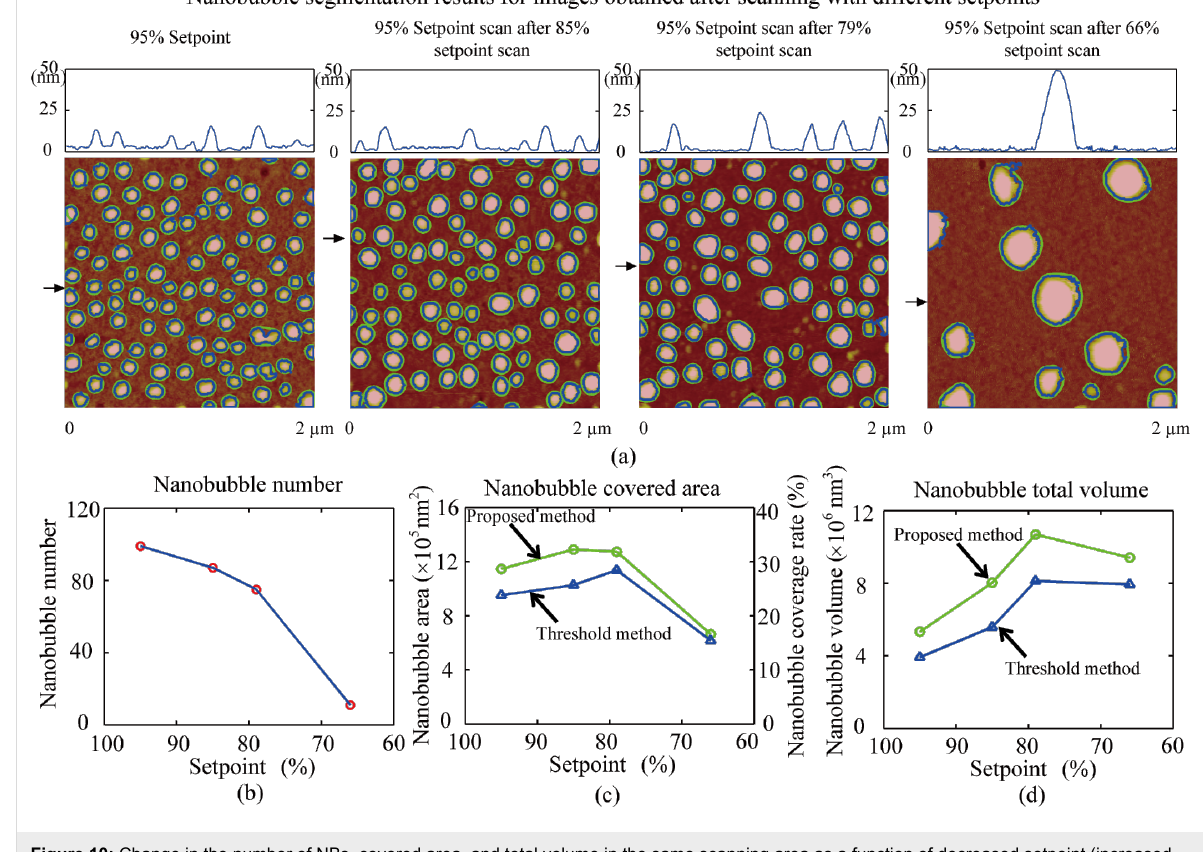
Figure 10: Change in the number of NBs, covered area, and total volume in the same scanning area as a function of decreased setpoint (increased scan load). (a) AFM image and corresponding segmentation results for a series of AFM images scanned with different setpoints. The first figure is the image scanned with a 95% setpoint. The second, third, and fourth images are the obtained with a 95% setpoint preceded by scanning with 85%, 79%, and 66% setpoints, respectively. With decreasing a setpoint, NB coalescence occurred, resulting in a decreased number of NBs and increased NB size. (b–d) number of NBs, covered area, and total volume in the same scan area as a function of applied setpoint. The number of NBs decreases with decreasing setpoint. The total covered area and total volume first increased and then decreased with the setpoint